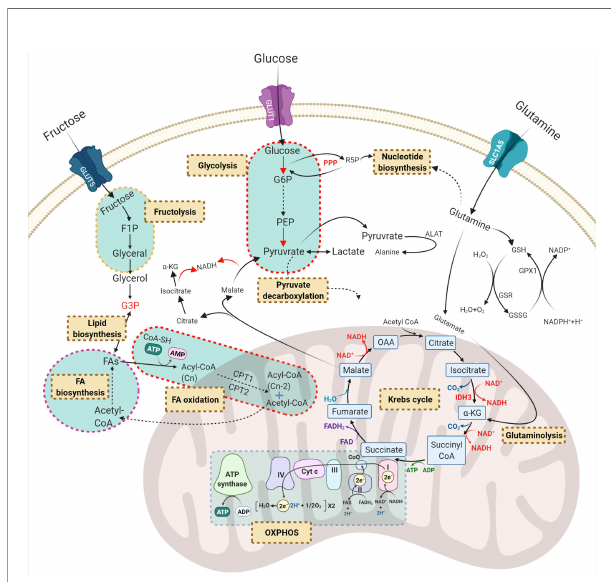
FIGURE 2 | Principal dysregulated metabolic pathways in AML. Carbohydrates and amino acids are two main sources of energy for AML cells which can be used in other metabolic pathways. Red , green , and purple texts are critical compounds in the relevant pathways. Brown-cream rectangles , indicating the crucial metabolic processes required for cell survival and proliferation. GLUT, glucose transporter; G6P, glucose-6-phosphate; R5P, ribose-5-phosphate; F1P, fructose-1-phosphate; PEP, phosphoenolpyruvate; G3P, glycerol-3-phosphate; OAA, oxaloacetate; a -KG, a -ketoglutarate; PPP, pentose phosphate pathway; ALAT, alanine transferase; GSH, glutathione; GSR, glutathione-disul fi de reductase; GPX1, glutathione peroxidase 1; FA, fatty acid; GLS, glutaminolysis; OXPHOS, oxidative